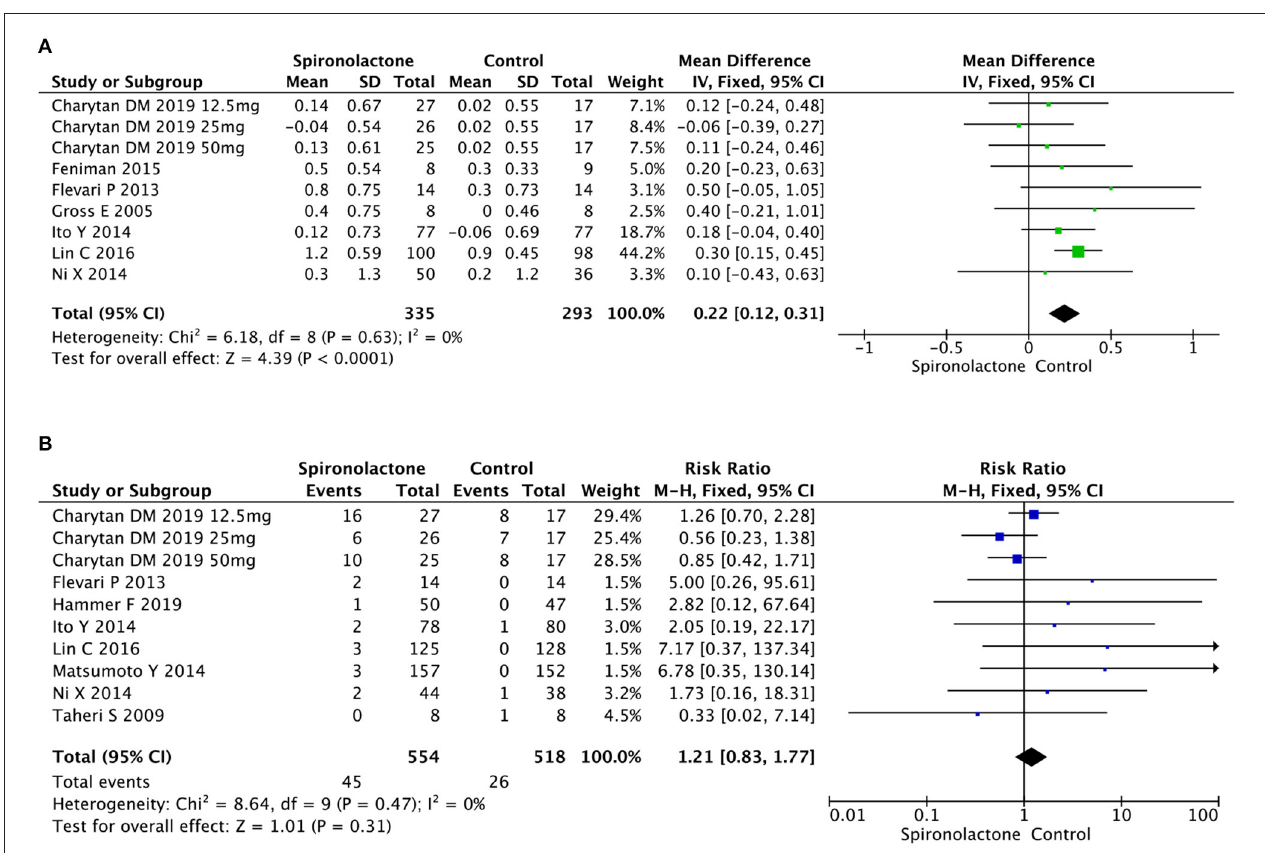
FIGURE 4 | (A) Effect of spironolactone on serum potassium; (B) Effect of spironolactone on hyperkalemia.